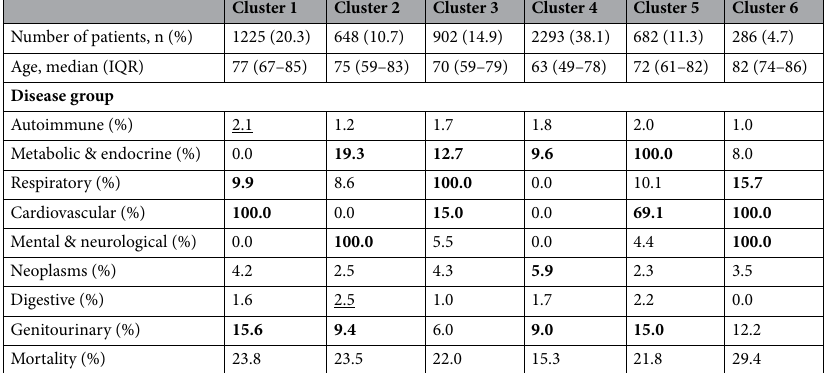
Table 4. Multimorbidity clusters in a population of hospitalised patients with COVID-19. Values in bold correspond to three conditions with the highest prevalence within patient groups (clusters of conditions). Underlined values represent other, less common conditions that have a higher prevalence than in other groups.